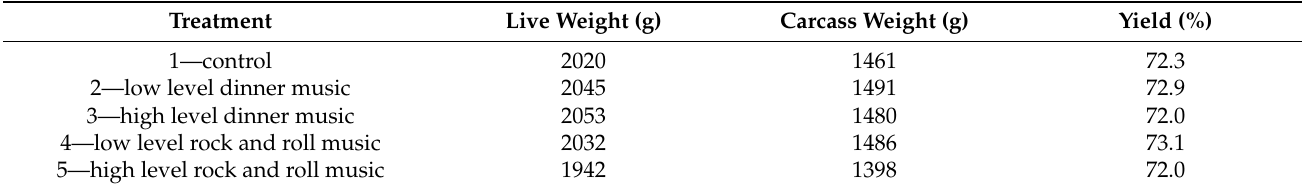
Table 3. Treatment means for live weight, warm dressed carcass weight and percent yield [79]. Treatment